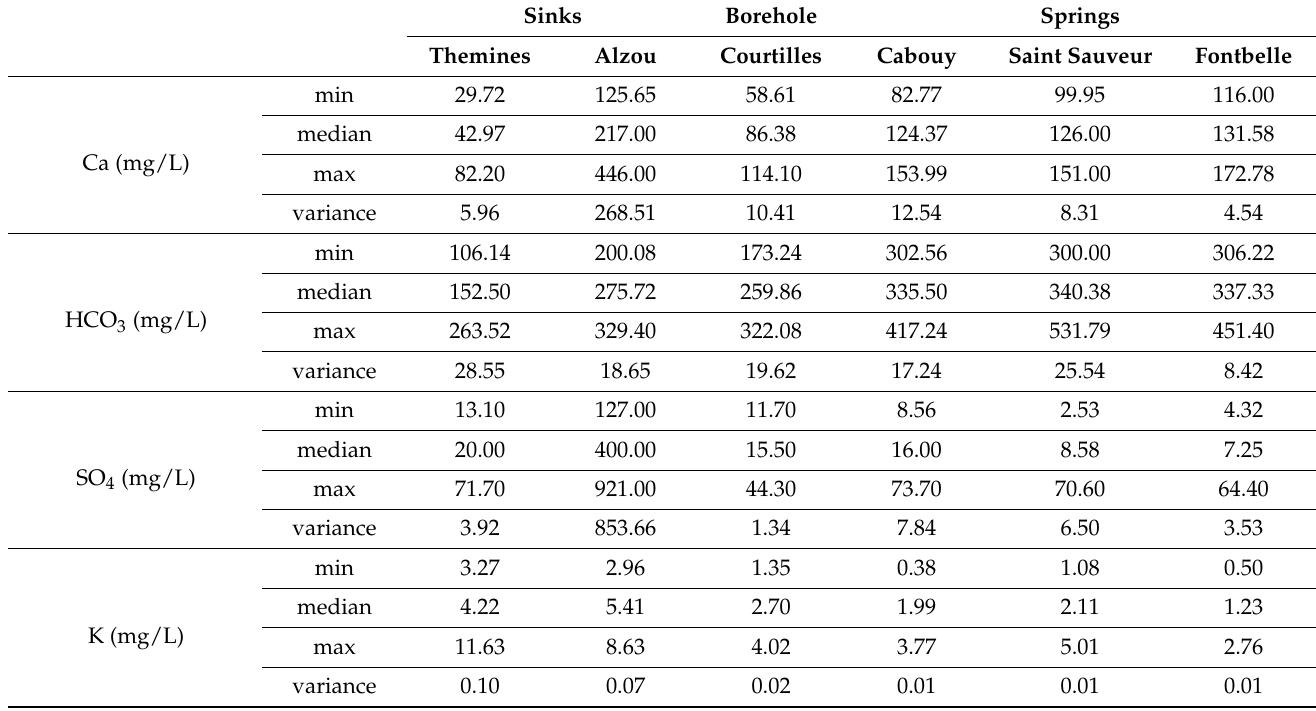
Table 4. Summary of statistics on the flow/water level, temperature, and conductivity at each monitored station.